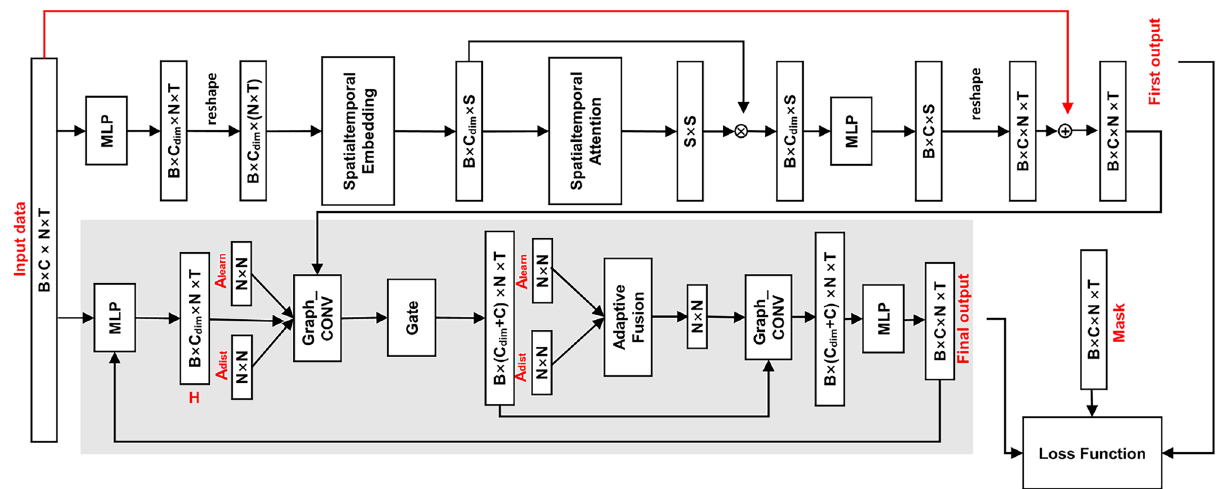
Figure 2. ADGCN model